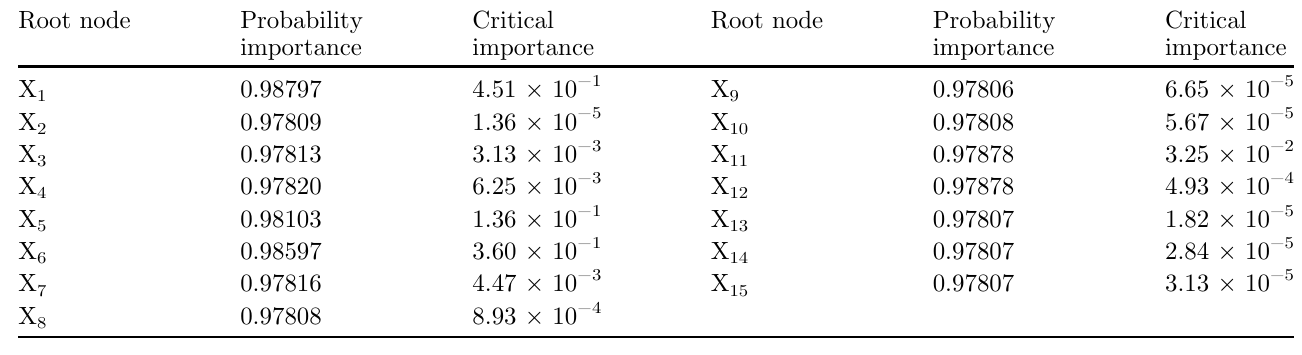
Table 5. Posterior probability of each root node.